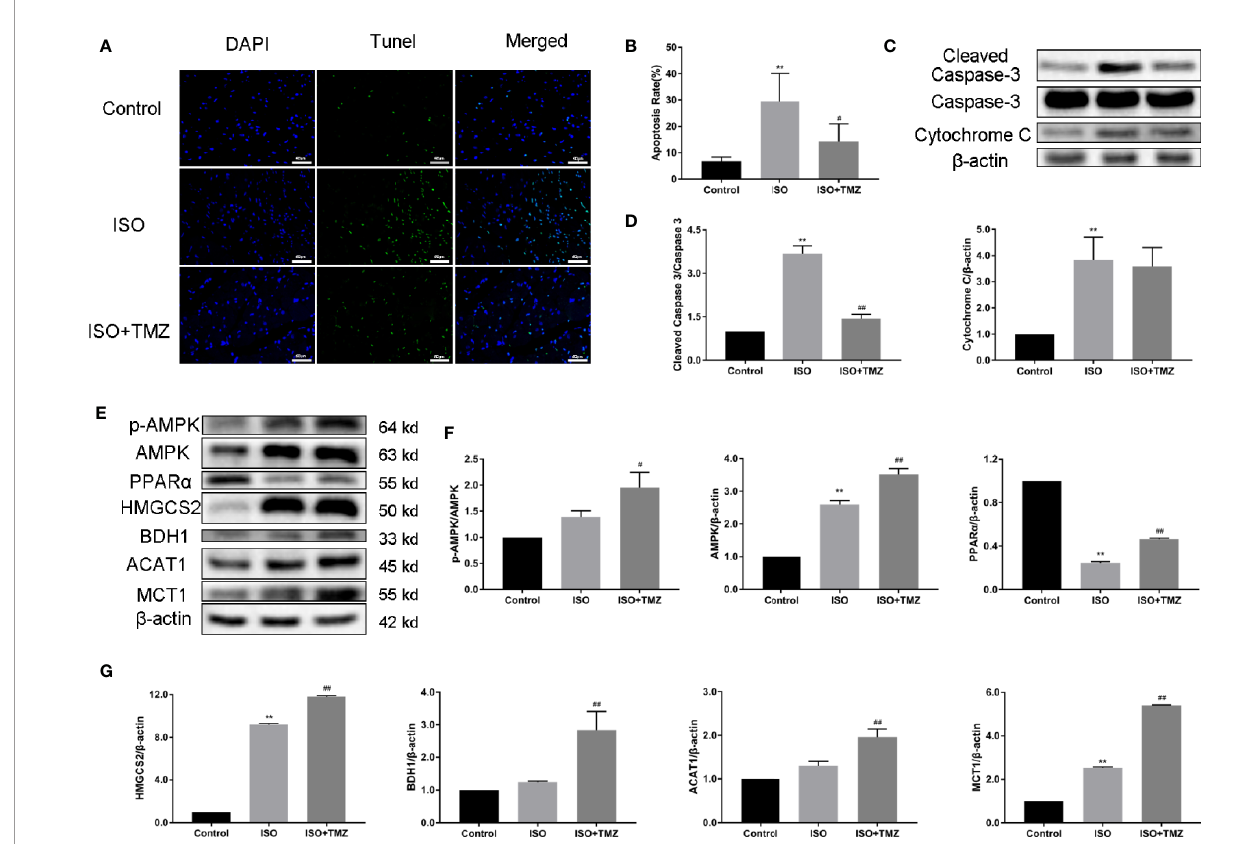
FIGURE 3 | Trimetazidine reduces cell apoptosis of myocardial tissues and increases the ketogenesis-related protein expression level of hepatic tissue in heart failure rats. (A) Representative images of DNA fragmentation as tested by tunel assay and DAPI staining (×400 magni fi cation) for different groups. (B) The number of apoptotic cells was calculated by taking fi ve views in each group (n = 5). (C) Western blot was used to detect the expression levels of cleaved caspase 3, caspase 3 and cytochrome C. (D) The density of the immunoreactive bands was analyzed by Image J software. (E) Western blot was used to evaluate ketogenesis-related protein expression. AMPK, p-AMPK, PPAR a , HMGCS2, BDH1, MCT1 and ACAT1 were included. (F, G) The histogram indicated the speci fi c relevant quantitative results (n = 3). Data are represented as means ± SD, # P < 0.05, ## P < 0.01 compared with ISO group, **P < 0.01 compared with control group. AMPK, adenosine monophosphate-activated protein kinase; p-AMPK, phospho-AMPK; PPAR a , peroxisome proliferator activated receptor a ; HMGCS2, 3-hydroxy-3-methylglutaryl- CoA synthase 2; BDH1, b -hydroxybutyrate dehydrogenase 1; MCT1, monocarboxylate transporter 1; ACAT1, acetoacetyl-CoA thiolase